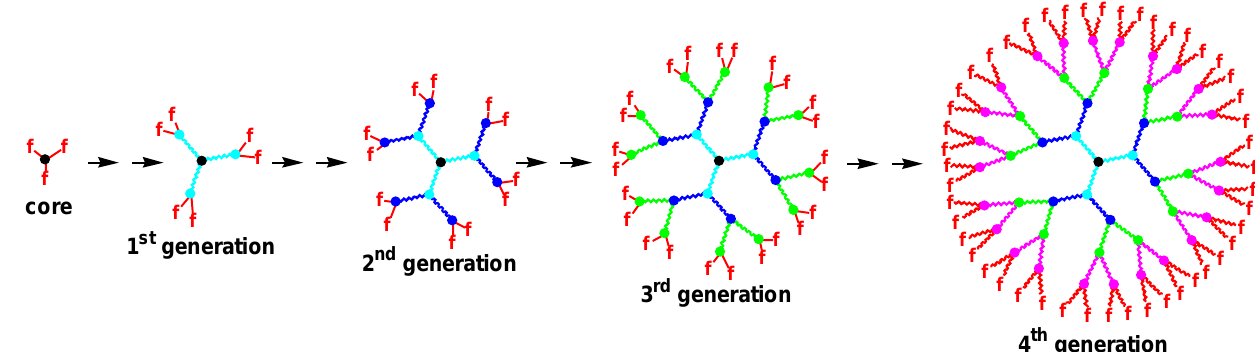
Figure 2. Schematization of the classical method of synthesis of dendrimers, showing the presence of the functional end groups